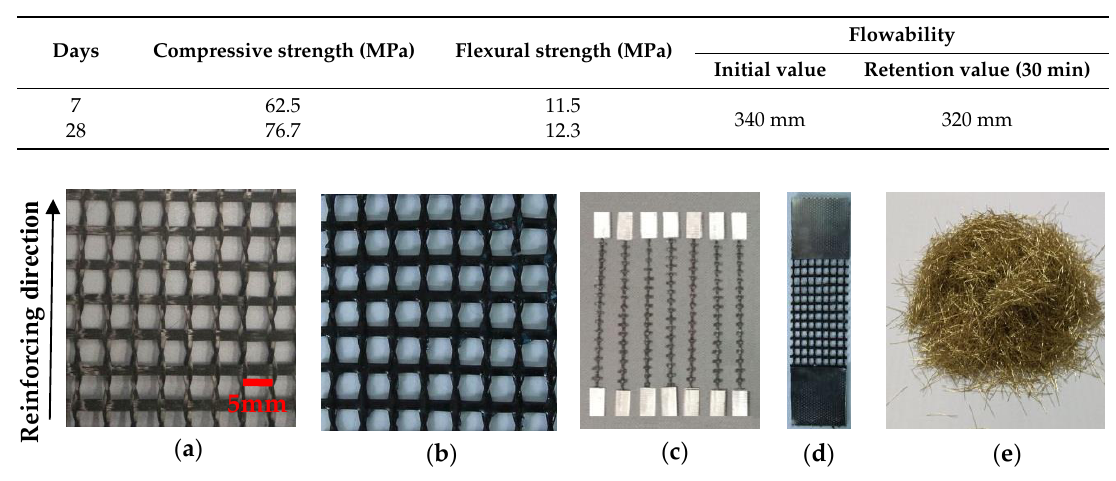
Table 5. Properties of the cementitious matrix.